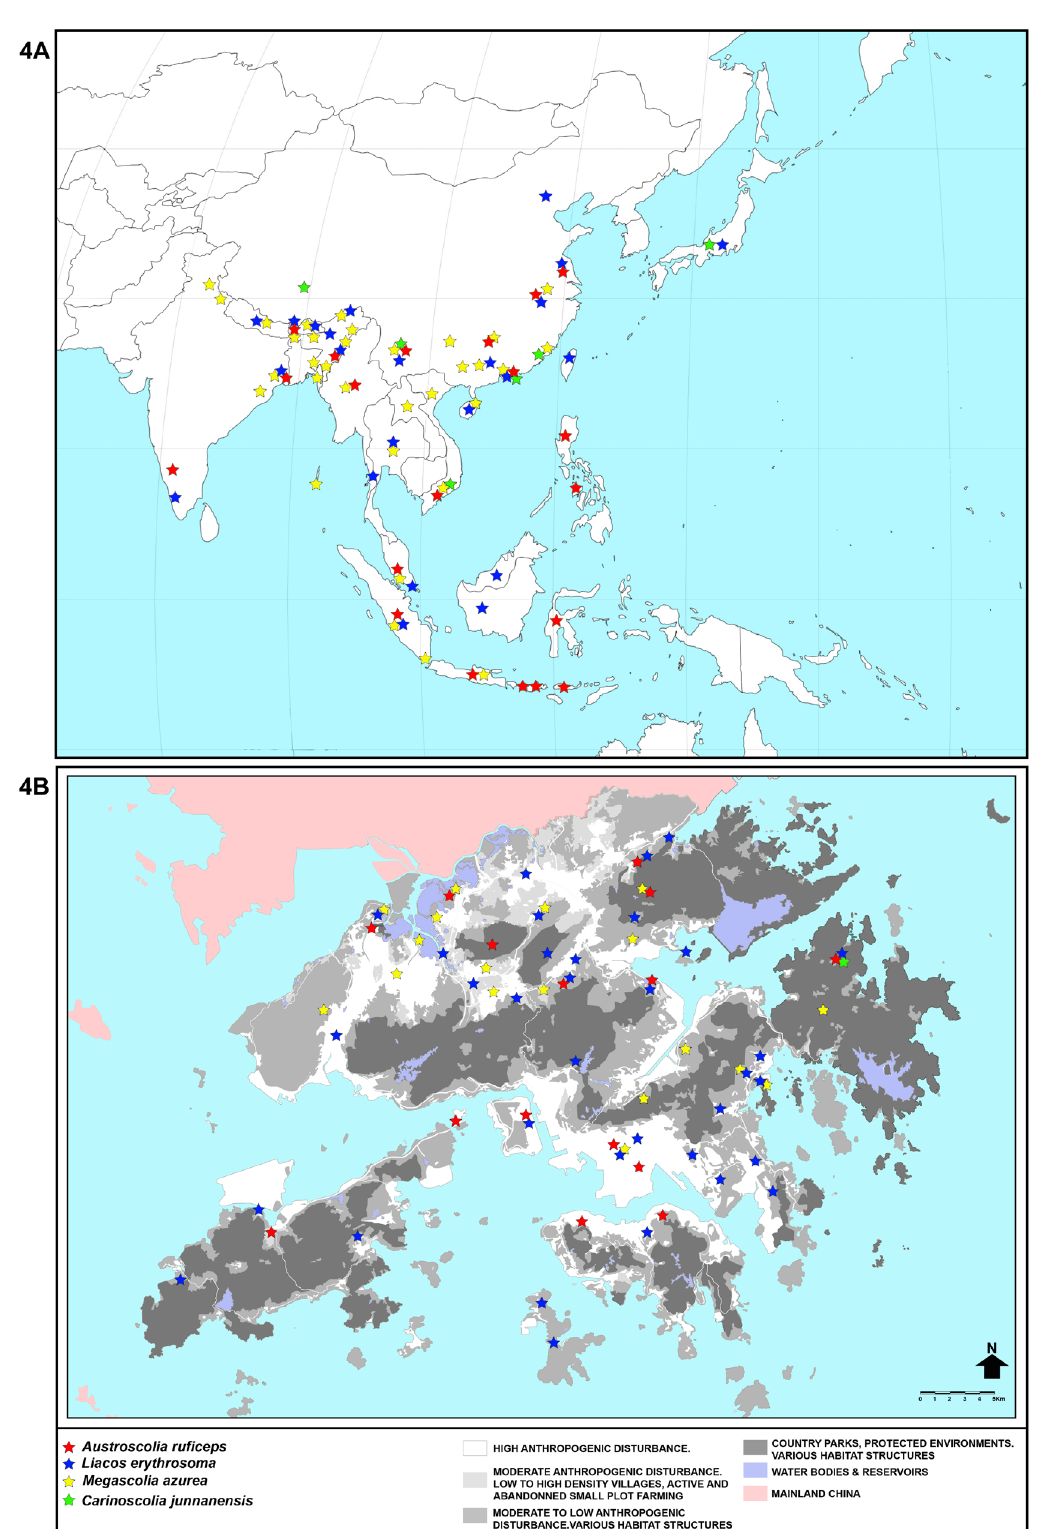
Fig. 4. Distribution of three species in the tribe Scoliini Latreille, 1802: Austroscolia ruficeps (Smith, 1855), Liacos erythrosoma (Burmeister, 1854), Megascolia azurea (Christ, 1791) and Carinoscolia junnanensis (Betrem, 1928). A . World distribution. B . Hong Kong